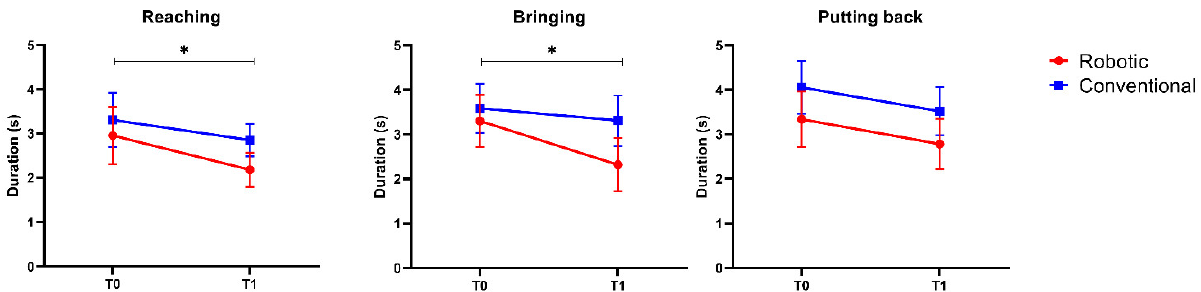
Figure 2. Values of the Duration index (efficiency) before (T0) and after (T1) the 30-session rehabilitation treatment, for the 3 analyzed phases of the drinking tasks, separately. Error bars represent the standard error. The symbol * indicates that the within-factor time was statistically significant ( p < 0.05).